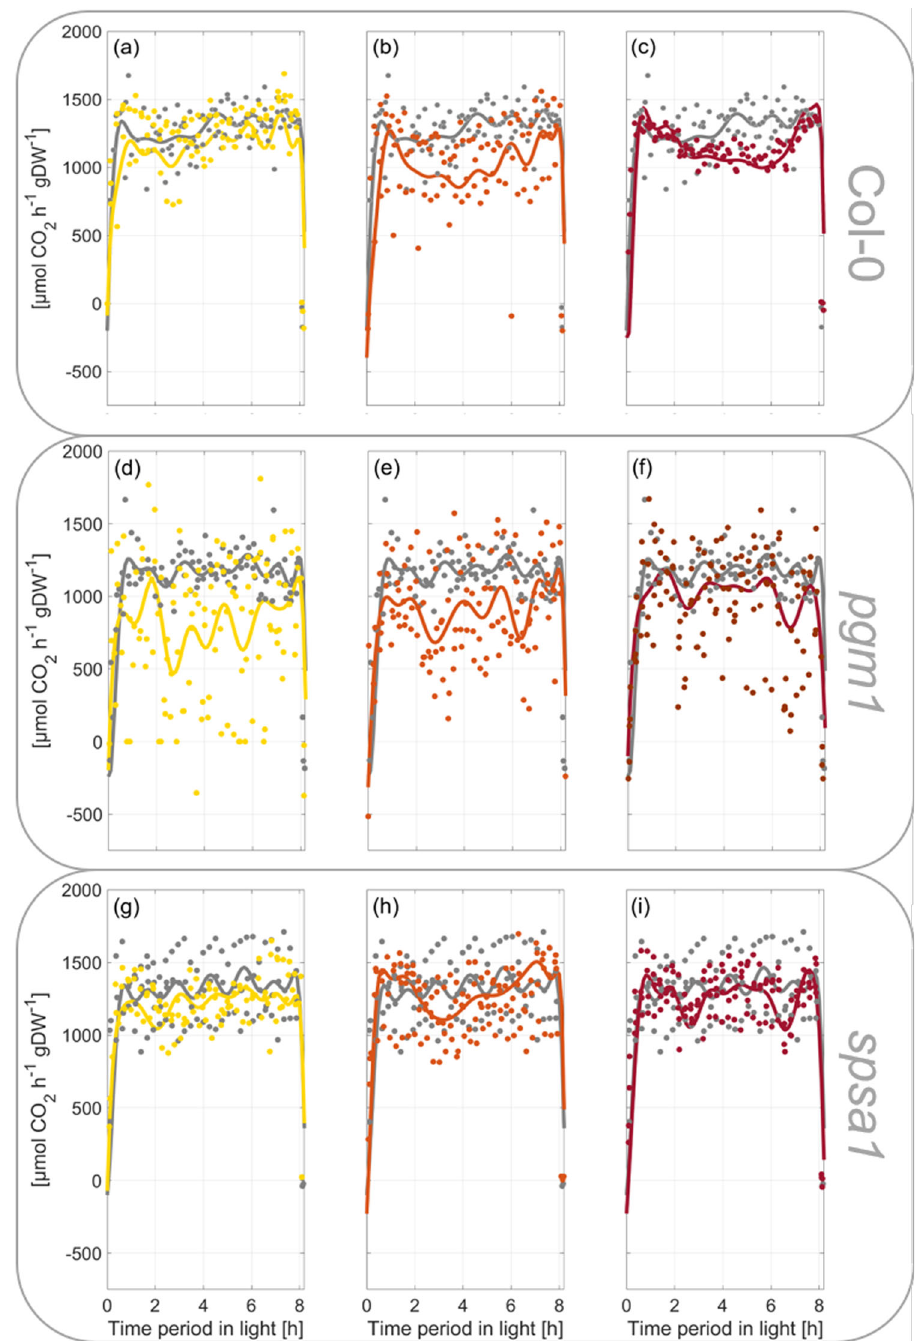
Fig. 2 Rates of net CO 2 uptake during short-day transient heat exposure. Scattered dots represent experimental data ( n = 3), lines represent Fourier series fi ts. a – c Col-0, d – f pgm1 , g – i spsa1 . Gray lines: 22 °C experiment; yellow lines: 32 °C experiment; orange lines: 36 °C experiment; red lines: 40 °C experiment. The temperature was set to 22 °C between 0 – 2 h and 6 – 8 h. The temperature was transiently increased between 2 and 6 h. Temperature curves recorded during the experiments are illustrated in Supplementary Fig. S3a. A summary of Fourier polynomial coef fi cients is provided in the supplements together with NPS data (Supplementary Data 1 and Supplementary Data